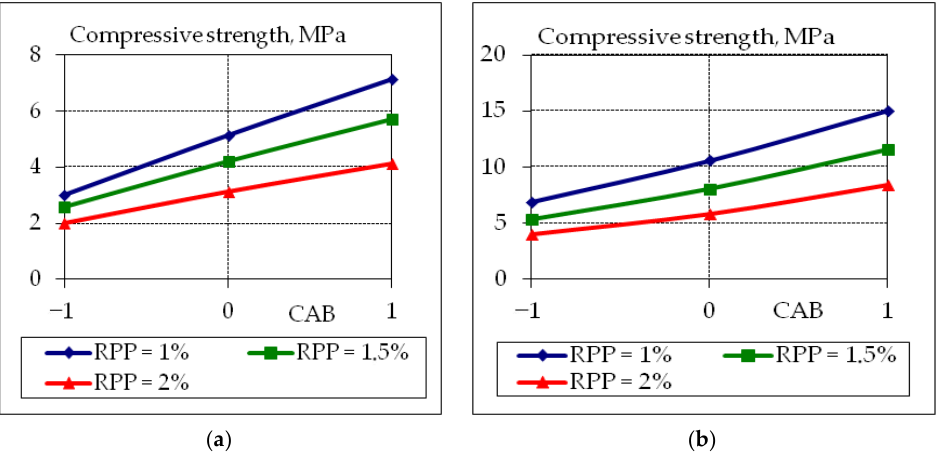
Figure 9. Graphical dependences of compressive strength at the age of 1 day ( a ) and 7 days ( b ) of fly ash concrete suitable for 3D printer, where the content of CAB − 1 = 15%; 0 = 17.5%; +1 = 20%.